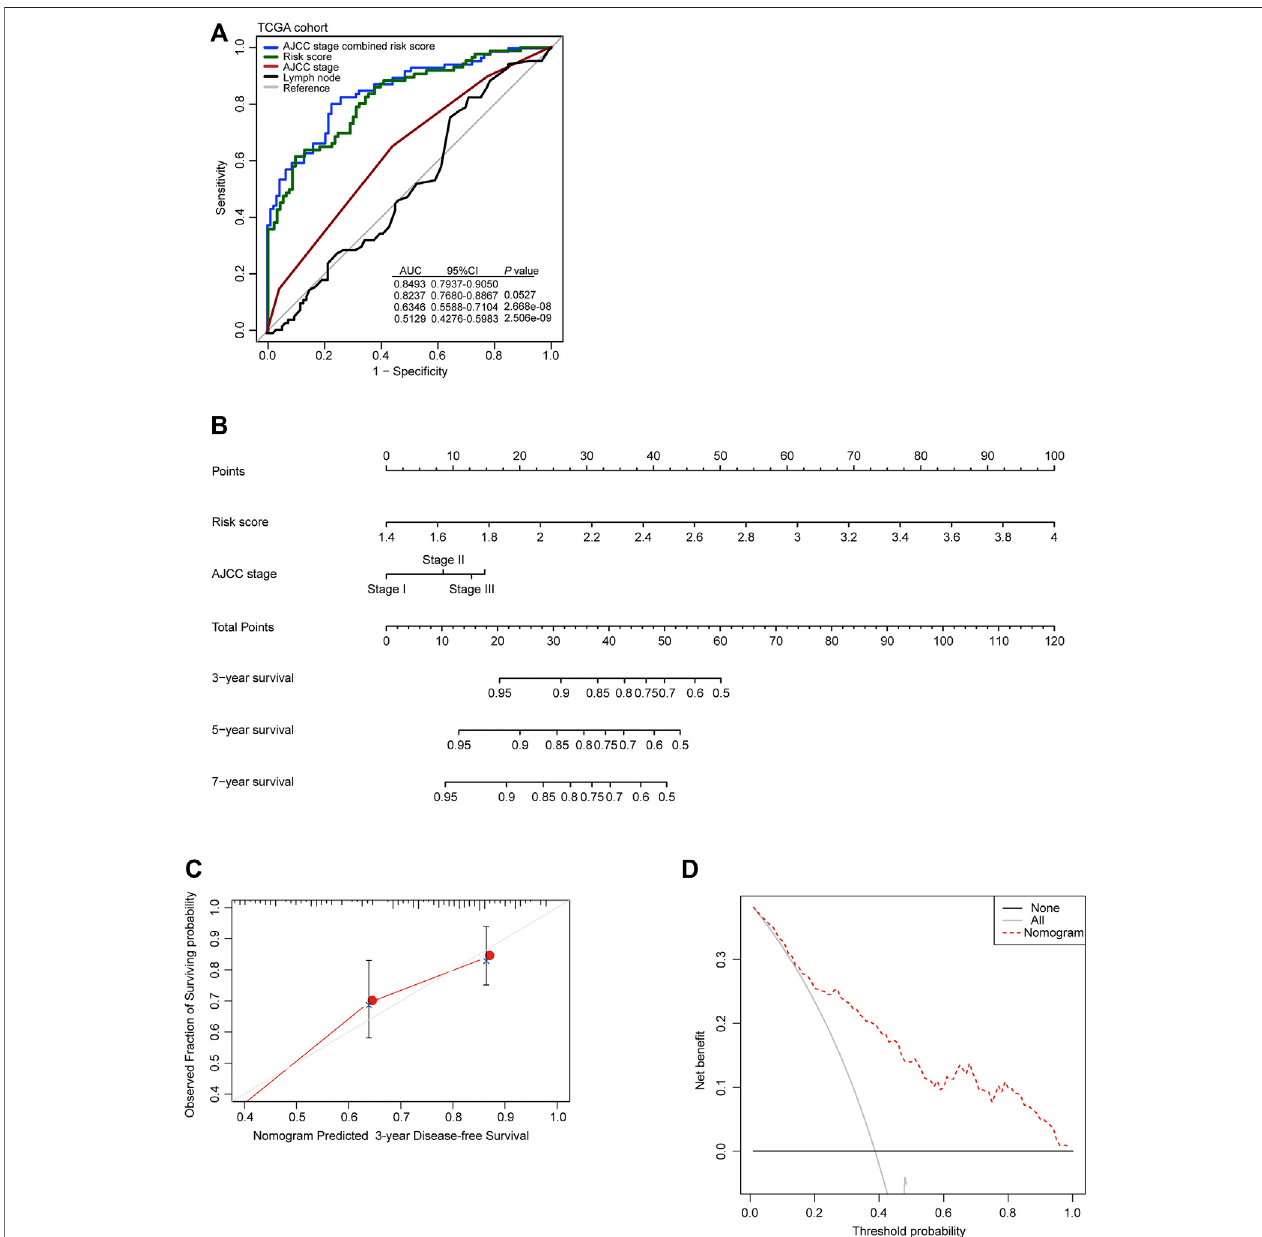
FIGURE 3 | Clinical value of the autophagy-related risk score model in gastric cancer. (A) Receiver operating characteristic (ROC) analysis of the sensitivity and speci fi city of the recurrence prediction by the risk score, AJCC stage, and the number of lymph nodes in TCGA cohort. p -values were from the comparisons of the area under the ROC curve (AUC) of risk score combined with AJCC stage versus risk score and AJCC stage separately. (B) The nomogram for predicting the proportion of patients with disease-free survival. (C) The calibration plots for predicting disease-free survival. Nomogram-predicted probability of recurrence is plotted on the x -axis; actual recurrence is plotted on the y -axis. The solid line represents our nomogram and the vertical bars represent 95% CIs. (D) Decision curve analysis (DCA) for assessment of the clinical utility of the nomogram. The x -axis represents the percentage of threshold probability, and the y -axis represents the net bene fi t.